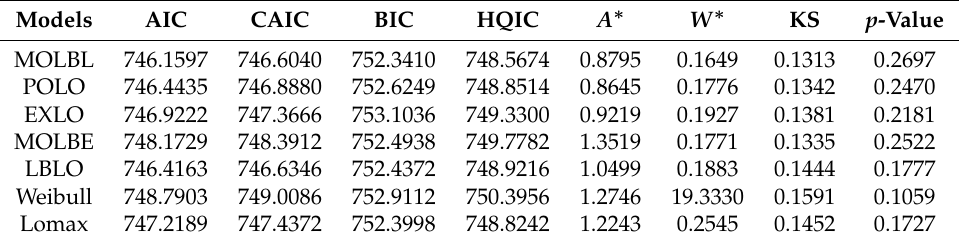
Table 8. Some criteria and goodness of fit measures for Data set